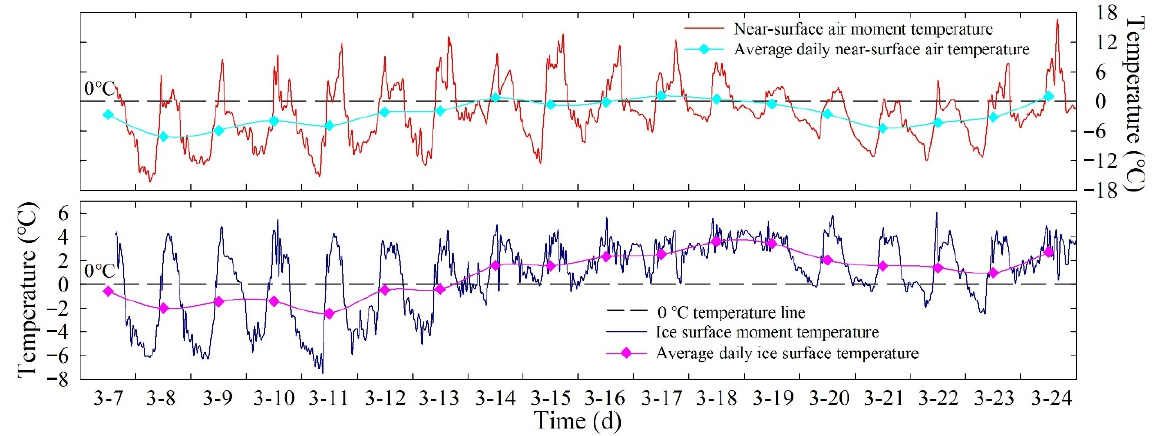
Figure 7. Changes in near-surface air and ice surface moment and average daily temperature.